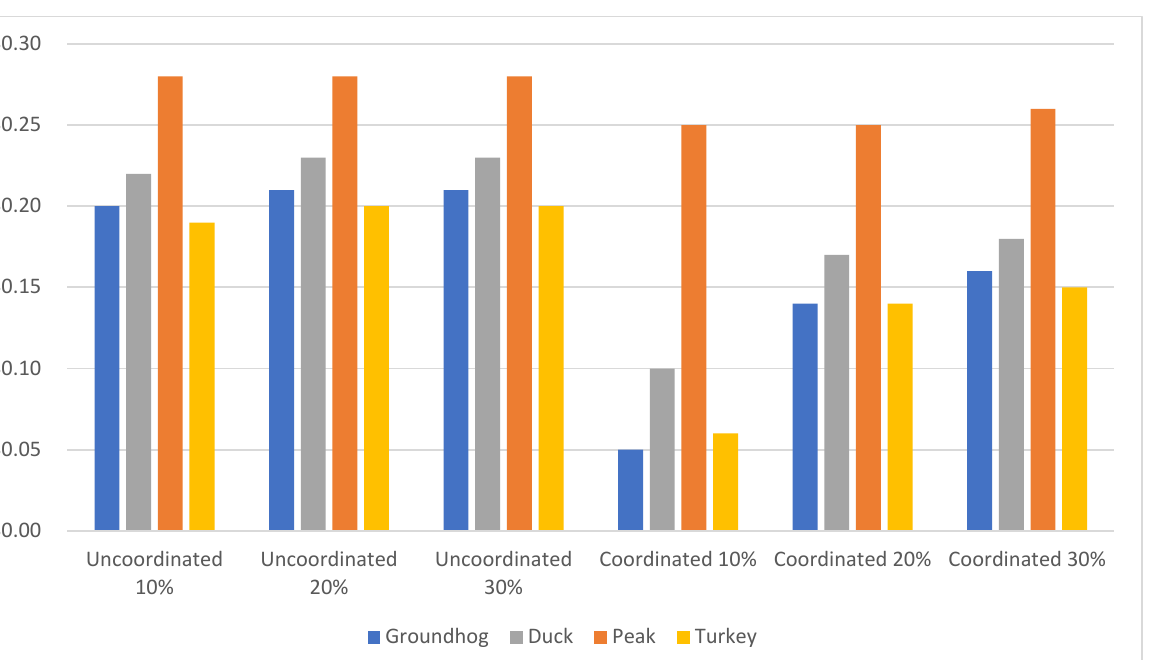
Table 9. Weekly average LMP (USD/MWh) occurring over the entire system (RTS-GMLC).